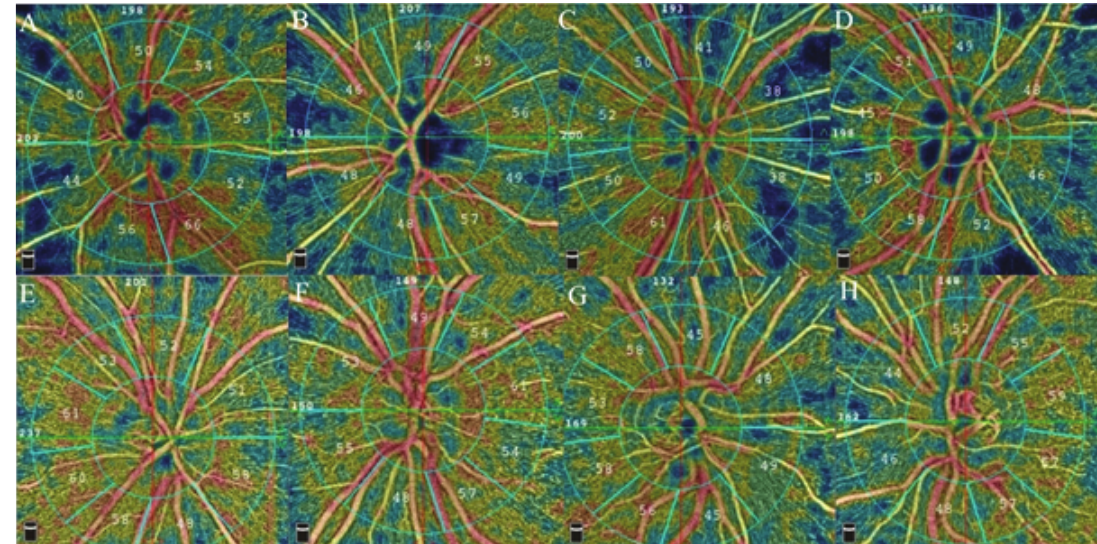
Figure 1. En-face optical coherence tomography angiograms (OCTA) segmented at the level of the radial peripapillary capillary (RPC) network from four recovered COVID-19 patients (A–D) versus four age-matched normal controls (E–H). Note the remarkable flow deficits present in the en-face angiograms from the COVID